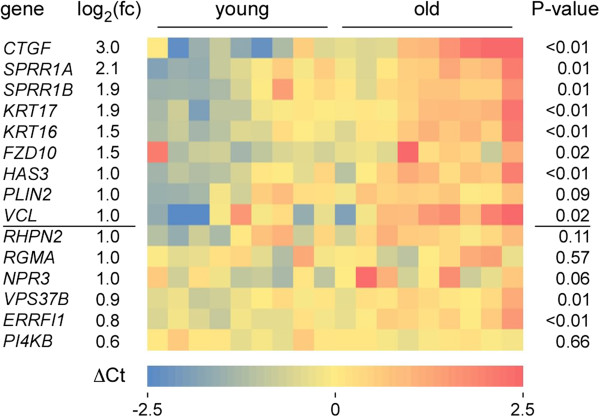
Validation of differential age-related gene expression in individual tissue samples. qRT-PCR was performed on RNA from epidermal suction blisters of 18 healthy female volunteers (9 young and 9 old volunteers). The heatmap shows processed ΔCt values. Gene expression differences of individual samples are indicated relative to the gene-specific, age-independent average expression level over all samples (blue: lower ΔCt, red: higher ΔCt). Numbers in the left colum indicate fold-change differences in gene expression between young and old, as determined by transcriptome sequencing. P values were determined by a Mann-Whitney U test and indicate the significance for differential gene expression. The line between VCL and RHPN2 separates genes with a ≥2-fold change in gene expression from genes with a <2-fold change.